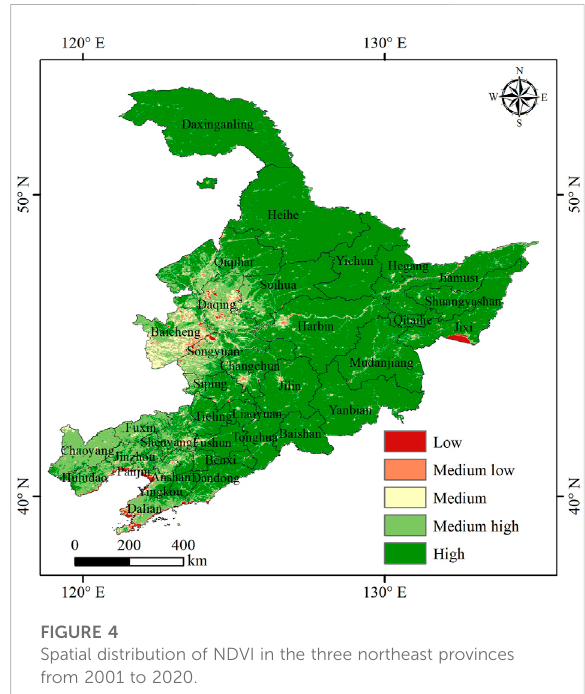
FIGURE 4 Spatial distribution of NDVI in the three northeast provinces from 2001 to